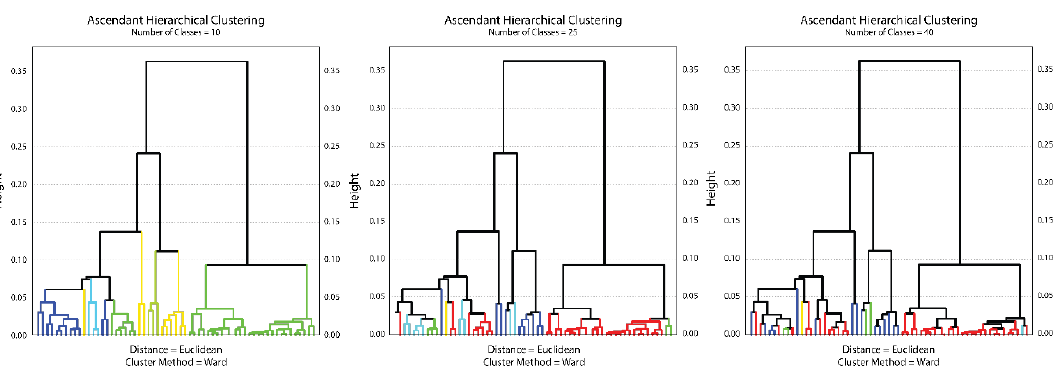
Figure 4. Distribution of self-organizing maps (SOM)-derived facies clusters and histograms, showing normalized training data. GR: Gamma-ray, NPHI: Neutron porosity, RHOB: Density.